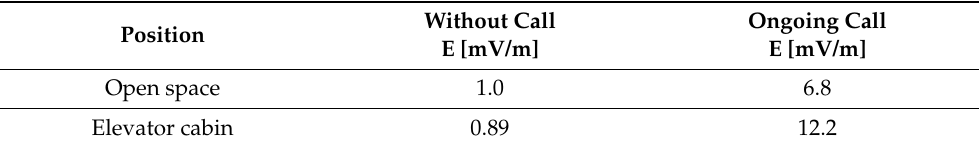
Table 2. Maximum values of electric field strength measured in head phantom for frequency band 1700–1800